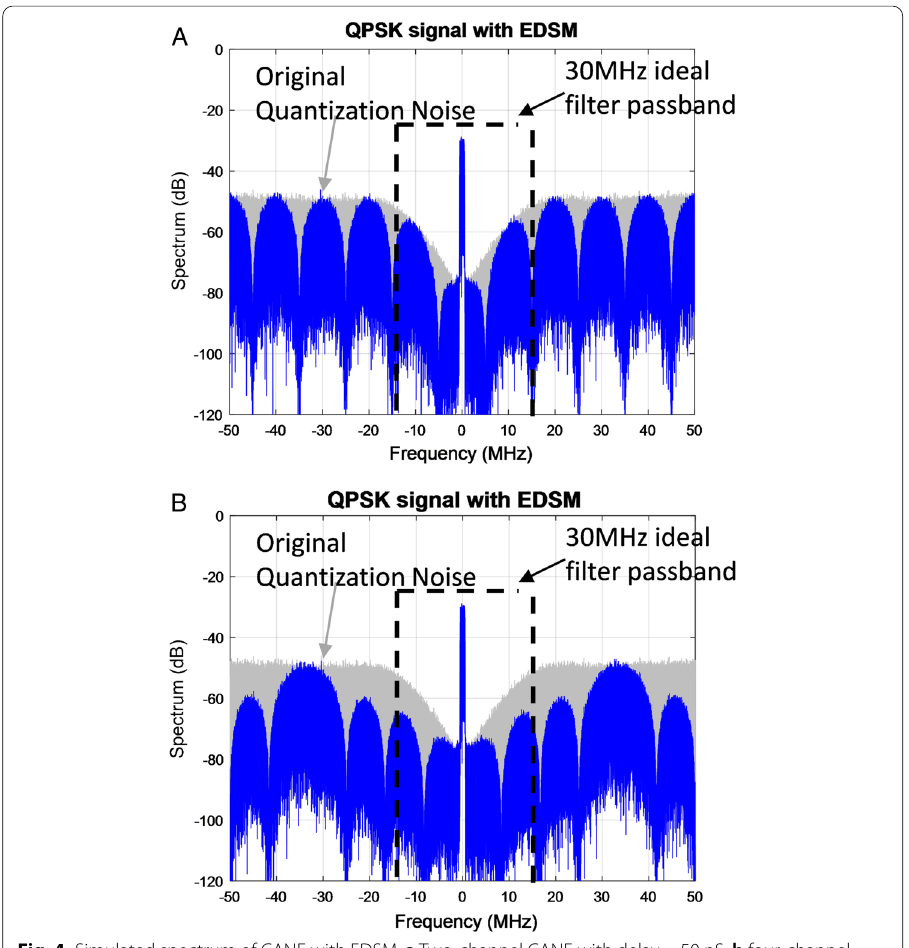
50 nS; b four-channel =